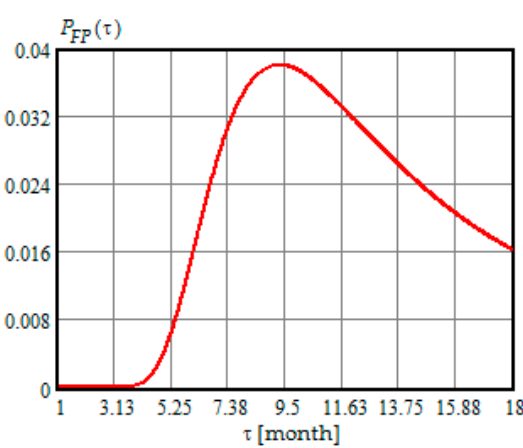
Figure 5. ( a ) Probability density function of time to failure; ( b ) Probability of failure.